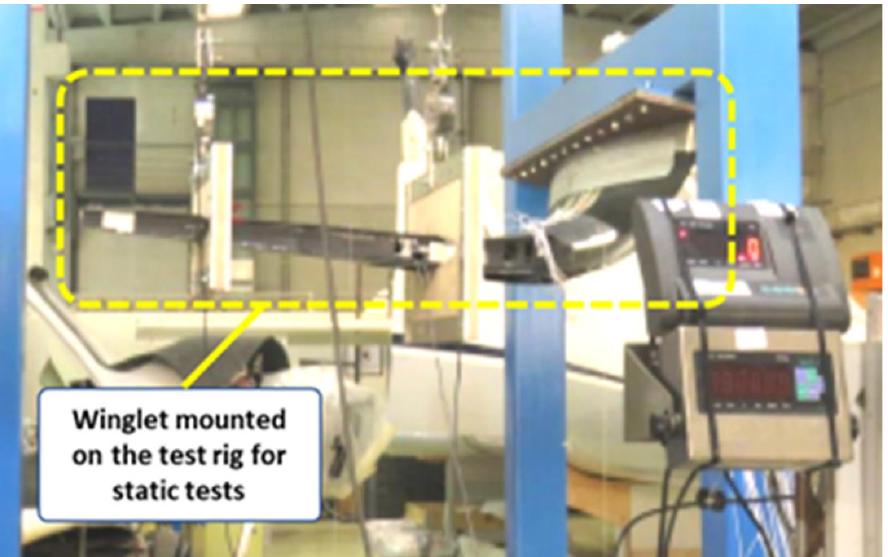
Figure 8. The full-scale demonstrator of the adaptive winglet (mounted on the test rig (Reprinted/ adapted with permission from Ref. [38] Copyright ©